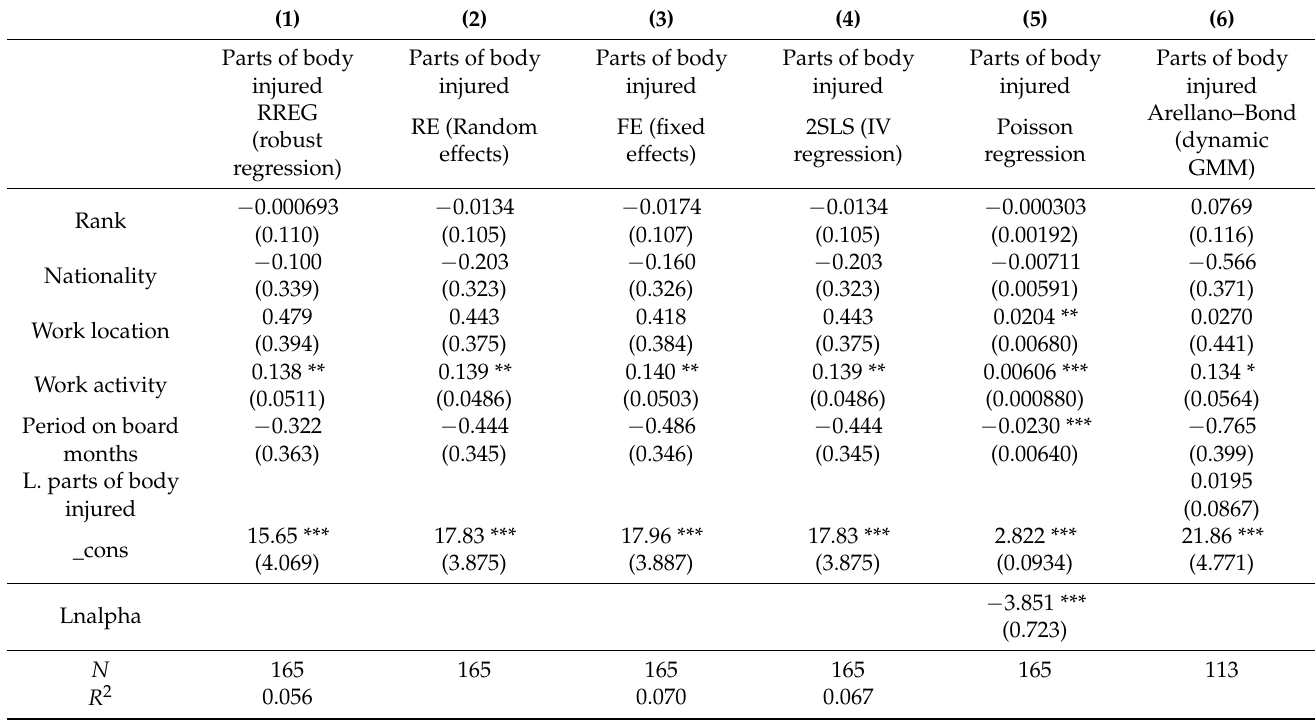
Table 3. Results of panel models (robust regression, random and fixed effects, two-stage least squares regression, Poisson regression, and dynamic GMM